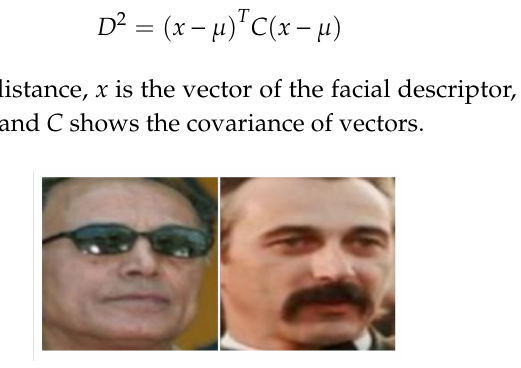
Figure 13. Image pair sharing the maximum correlation coe ffi cient in the example of the LFW.